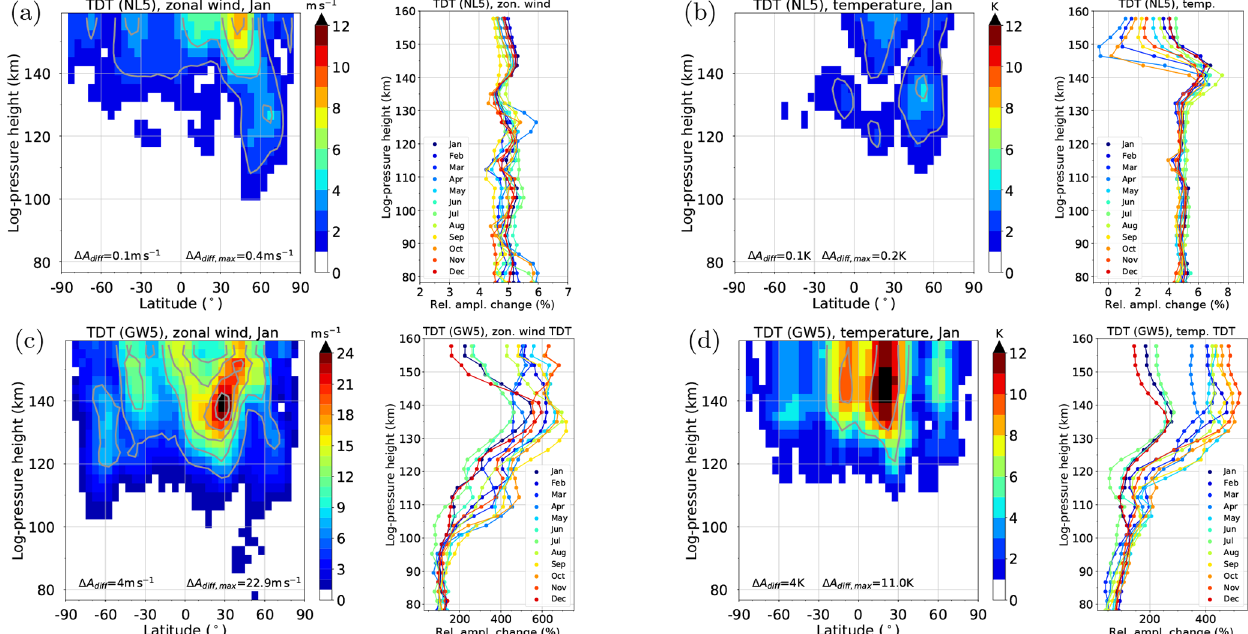
Figure 3. Color plots: latitude–altitude distribution of TDT zonal wind (a, c) and TDT temperature amplitudes (b, d) in the NL5 (a, b) and GW5 (c, d) simulations for the January ensemble mean. Contour lines denote differences to the NLIN (a, b) and GWF (c, d) ensemble simulations. Vertical profiles show the monthly mean horizontal mean TDT amplitudes, displayed as a relative change compared with NLIN (a, b) and GWF (c, d) , respectively. Different colors refer to different months (see legend). Note that the scales are